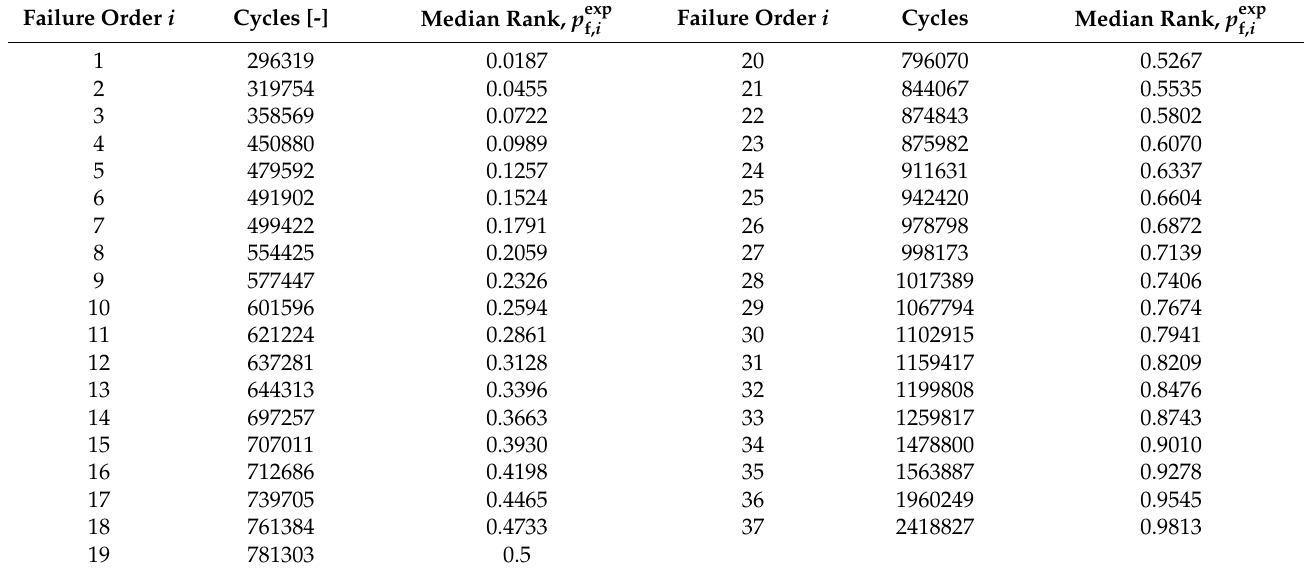
Table 1. Fatigue test data for single-pass tee joint test specimens and median rank estimates. All specimens are fatigue-loaded at R = 0.1 and amplitude 180 MPa.